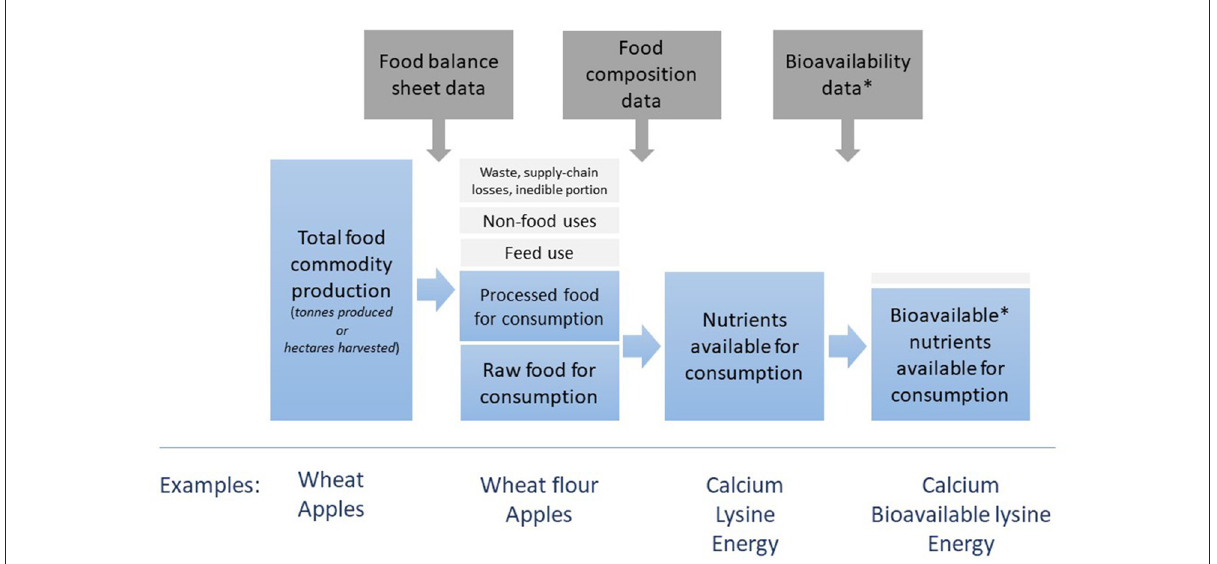
FIGURE1 Illustration of the DELTA Model ® calculation process. See section 2 for more detailed description. Some examples of food commodities, foods, and nutrients are shown for each stage of the calculation. Note that the calculation can be performed either in units of tons, or hectares of